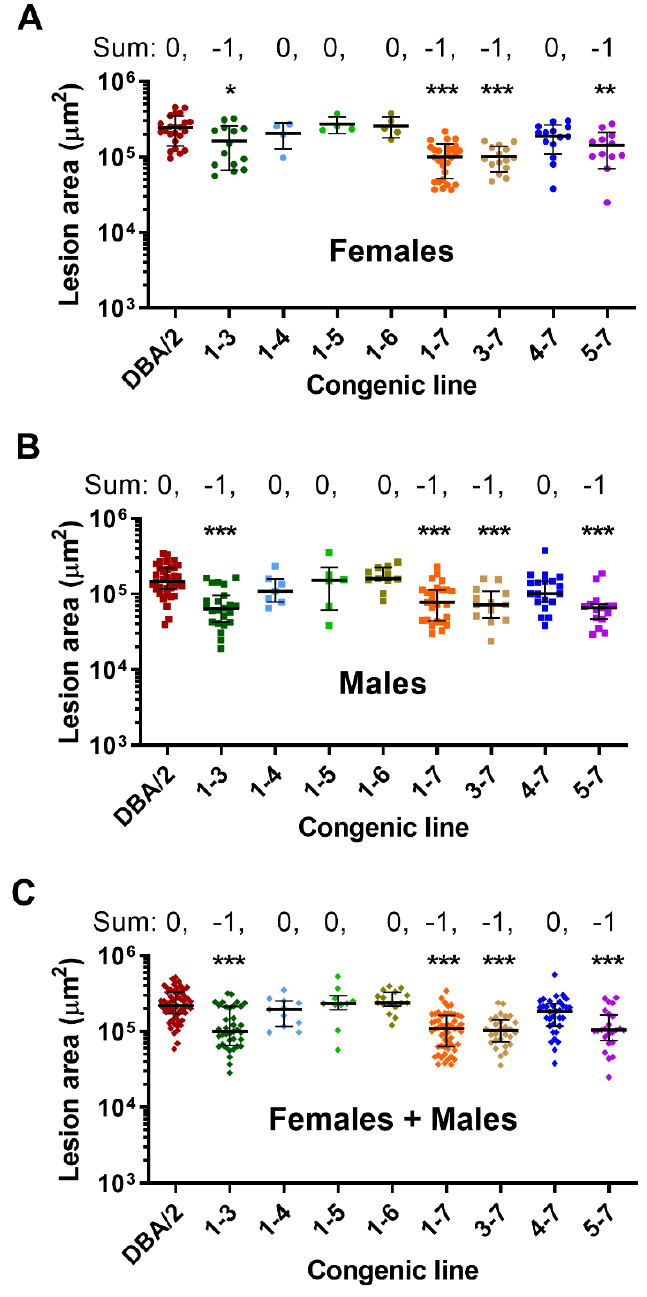
Figure 2. Aortic root lesion areas in female mice ( A ), male mice ( B ), and combined sexes after sex adjustment ( C ). Lesions were compared against the DBA/2J strain, in females the data were normally distributed (mean ± S.D. shown) and analyzed by one-way ANOVA and Dunnett’s multiple comparison test. Males and combined sex lesions (median ± I.Q.R shown) were analyzed by non- parametric Kruskal–Wallis test with Dunn’s multiple comparison test. *, p < 0.05; **, p < 0.01; ***, p < 0.001. The sum above the lesion data indicates the lesion change expected based on inclusion of the Ath28.1 ( − 1, the AKR/J allele decreases lesion area), Ath28.2 (+1, the AKR/J allele increases lesion area), and Ath28.3 regions ( − 1).